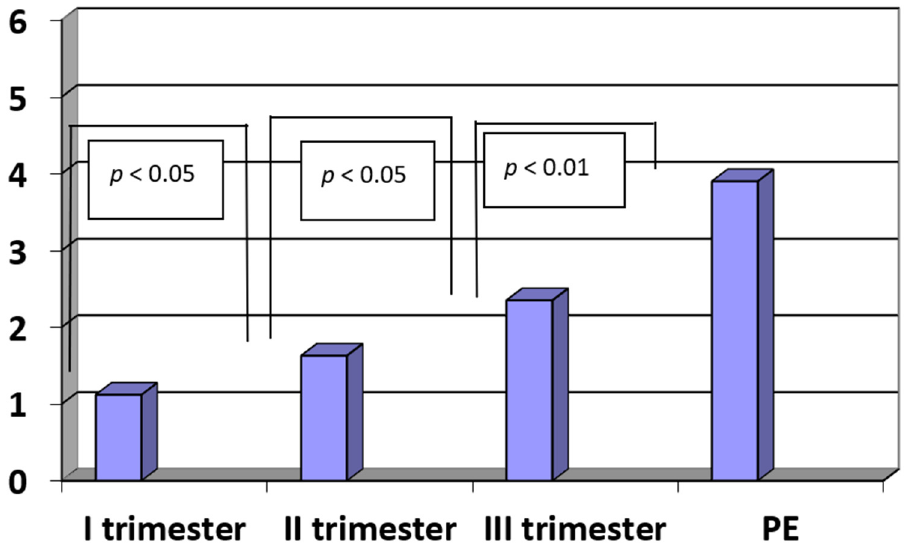
Figure 2. The concentrations of interleukin-17 (IL-17) (pg/mL) in sera of patients with PE (n = 35) and in sera of women in the first, second and third trimesters of normal pregnancy (n = 45). In the group of patients with pre-eclampsia, the levels of IL-17 positively correlated with systolic blood pressure (R = 0.42; p < 0.01). On the other hand, the concentrations of